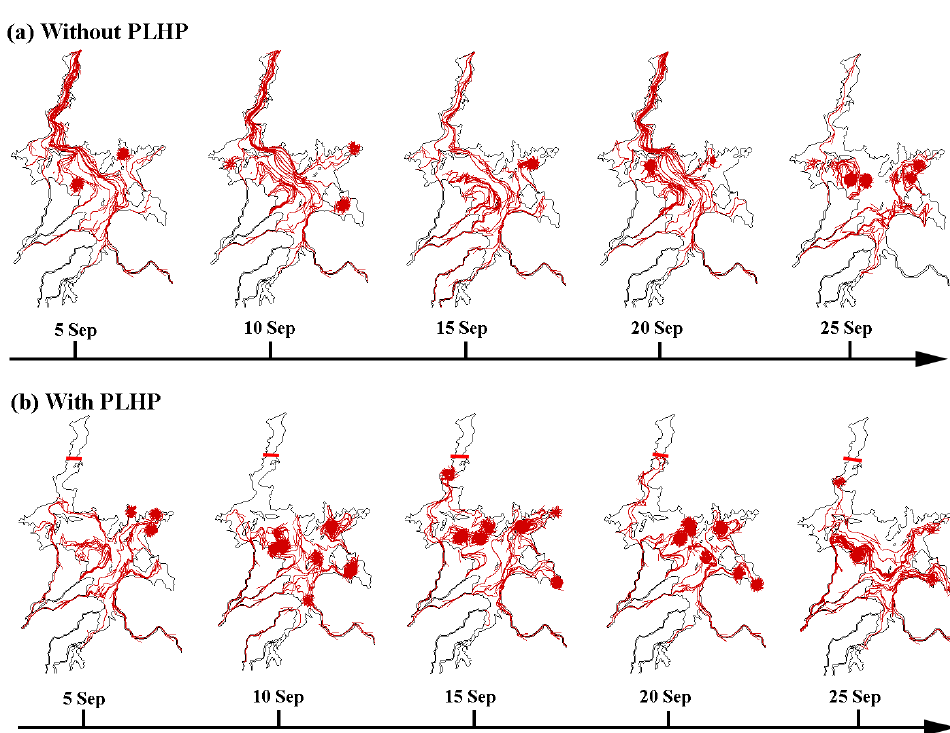
Figure 8. Influence of the PLHP on the spatial flow field based on velocity components and streamline (in dark red line) under the ( a ) natural condition and ( b ) hypothetical condition.